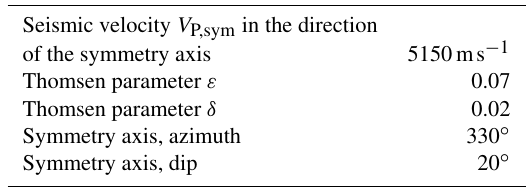
Table 2. Anisotropic seismic velocity parameters used for JHD.